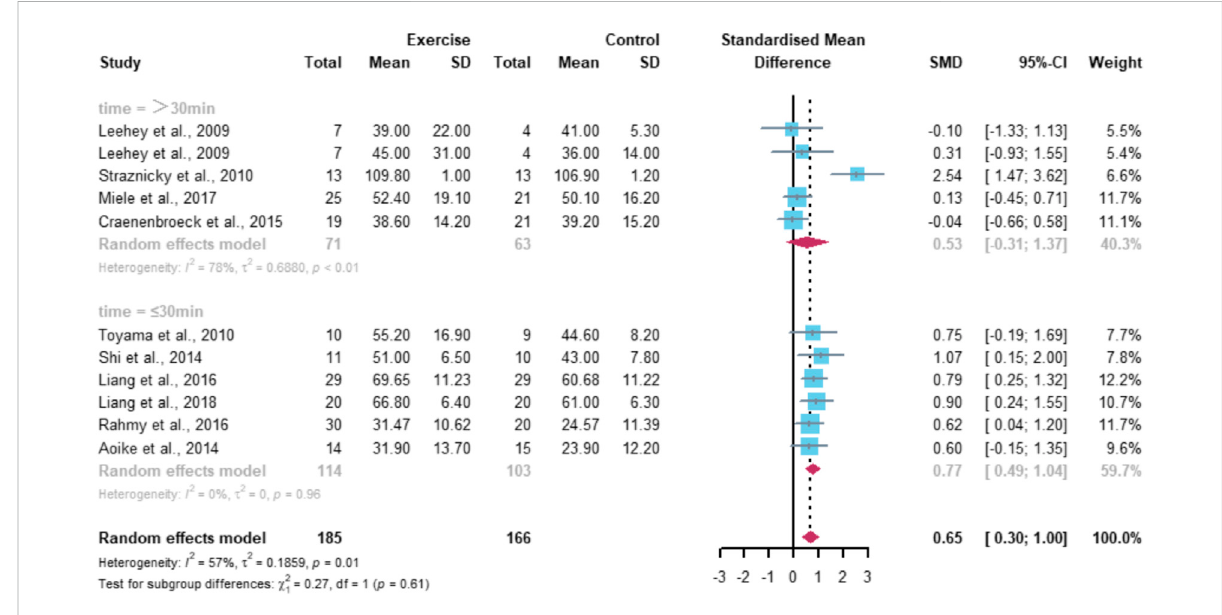
Subgroup analysis of the effect of aerobic exercise on eGFR.